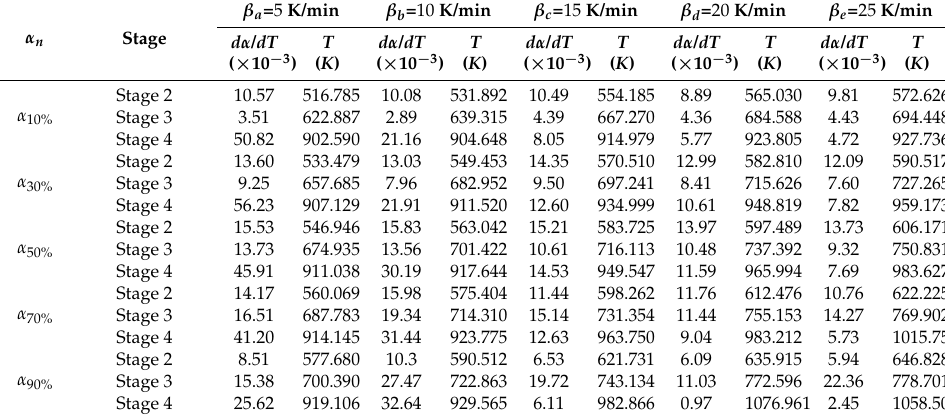
Table 7. Parameters for incineration kinetic modeling in stages two, three, and